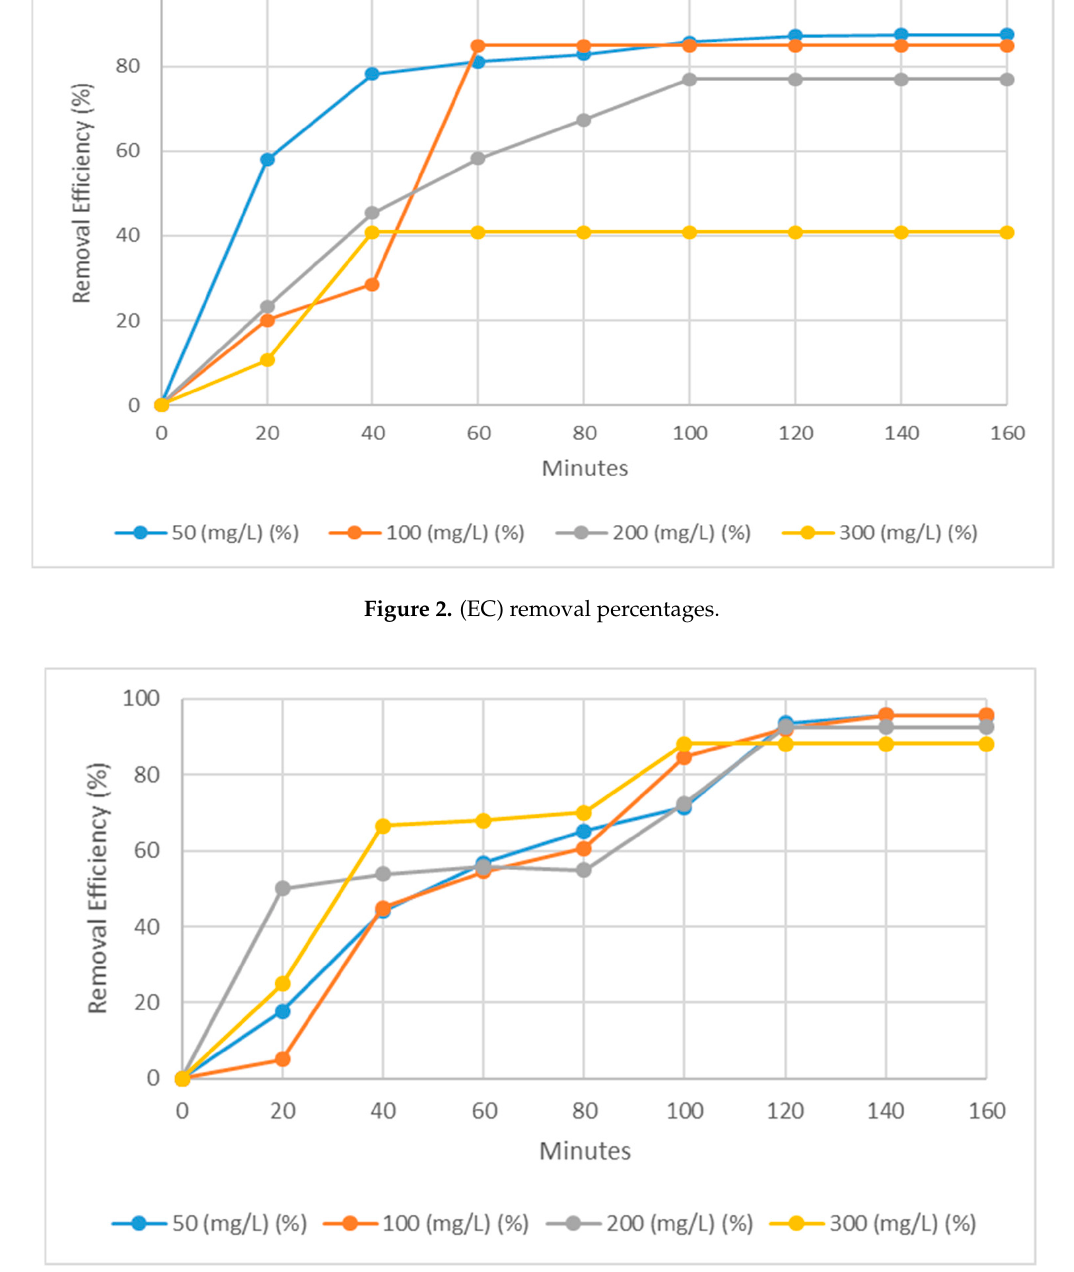
Figure 3. (EC + Fe) removal efficiency.